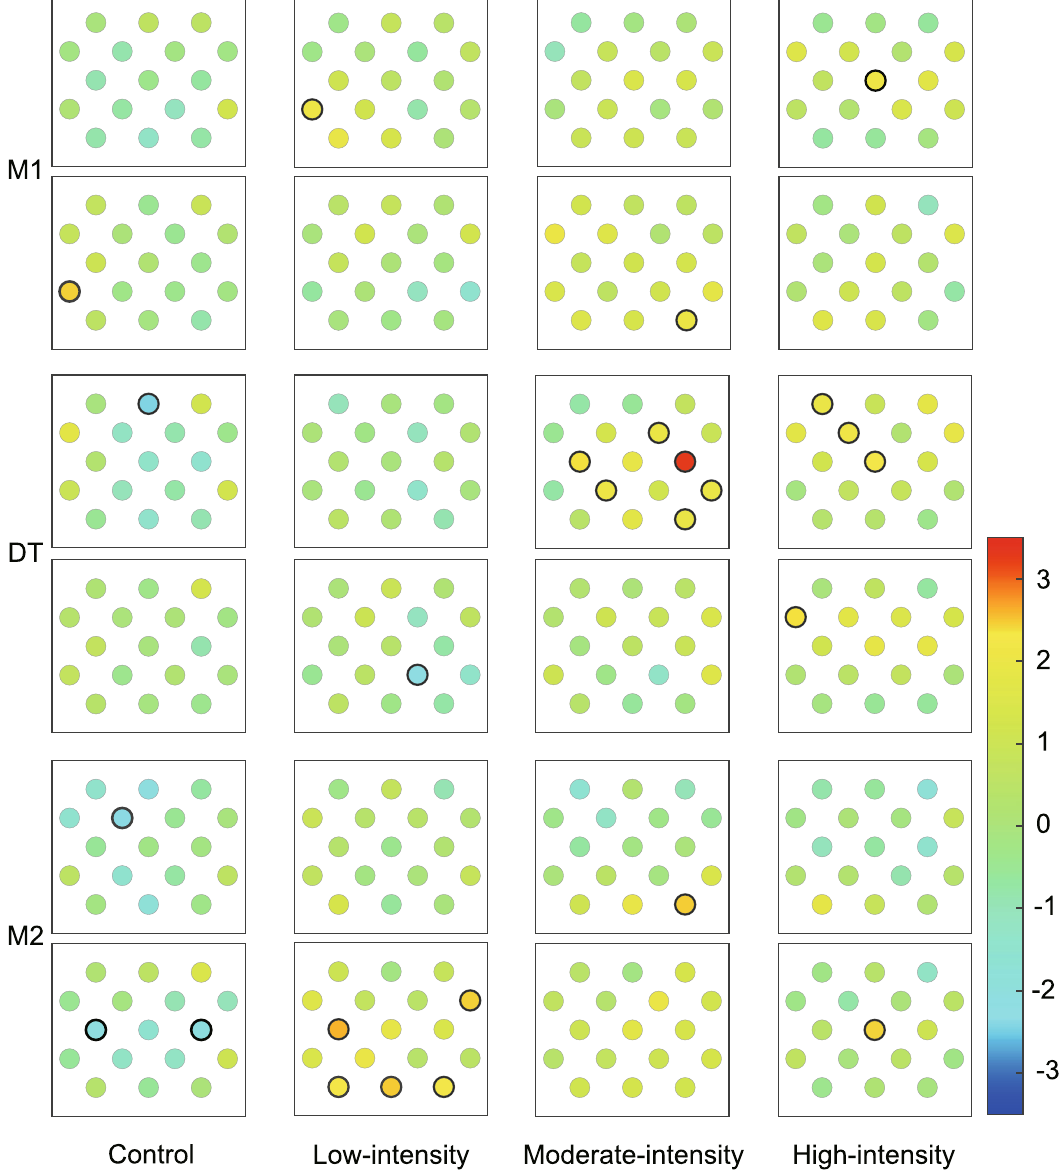
condition. The high-intensity condition (60% of the VO 2 peak) was beyond the anaerobic threshold (AT), which is 46–56% of the VO 2 peak 63–65 . Since it may take more than 2 min for the oxygen uptake to reach the steady state at load intensities higher than AT 66 , it is possible that the oxygen uptake had not reached the steady state during the 2-min warm-up under the high-intensity condition. Nevertheless, there was no significant differ- ence in the oxygen uptake values between DT and M2 under the high-intensity condition. From these facts, it is plausible that the participants’ body circulation of oxygen had reached a steady state except for M1 under the high-intensity condition. We found different PFC activities depending on the task periods and the exercise intensities: PFC activity was significantly higher in M1 and DT under moderate-intensity and high-intensity conditions, but not under control or low-intensity conditions. This result indicates that a threshold of the exercise intensity that facilitates